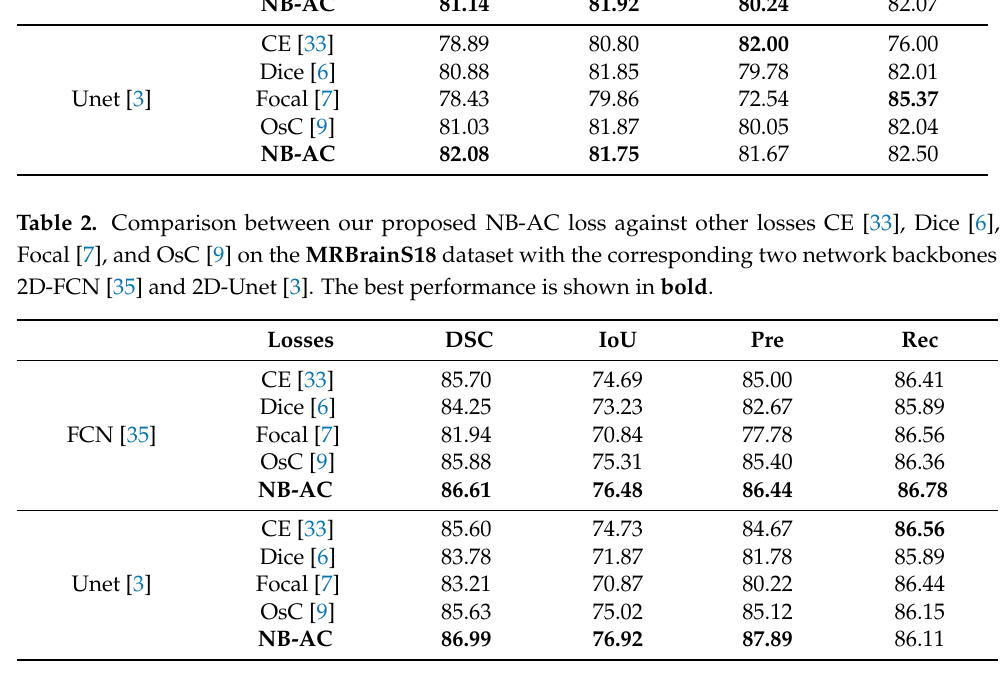
Table 3. Comparison between our proposed NB-AC loss against other losses CE [33], Dice [6], Focal [7], and OsC [9] on the BRATS 2018 dataset with the corresponding two network backbones 2D-FCN [35] and 2D-Unet [3]. The best performance is shown in bold .